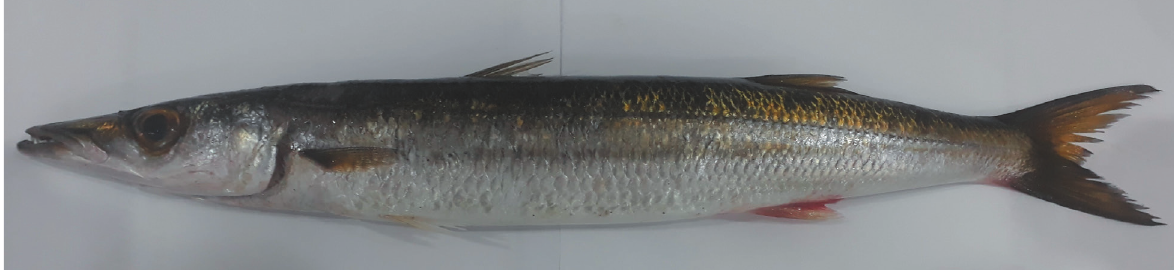
Fig. 2. Specimen of Sphyraena flavicauda caught at Chetaibi, Algeria in February 2019 showing the position of the dorsal, pectoral, and ventral fins and the lower brownish-yellow longitudinal